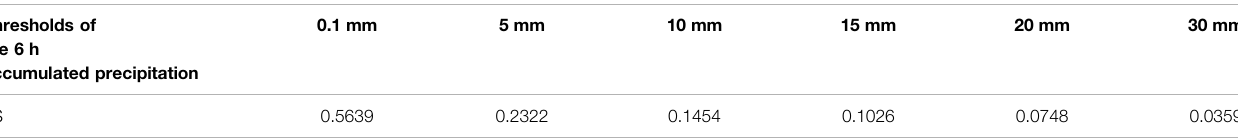
TABLE 2 | Threat scores of accumulated precipitation forecasts in 6 h during four WRWS cases in 2017 over coastal areas of YHR (30 ° – 35 ° N, 116 ° – 122.75 ° E). Thresholds of the 6 h accumulated